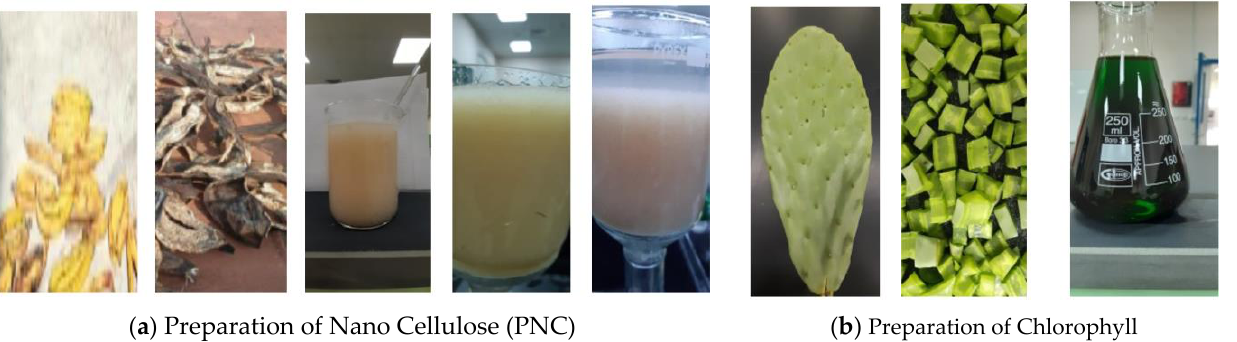
Figure 1. Photographs of the preparation of ( a ) nanocellulose (PNC) and ( b ) chlorophyll.